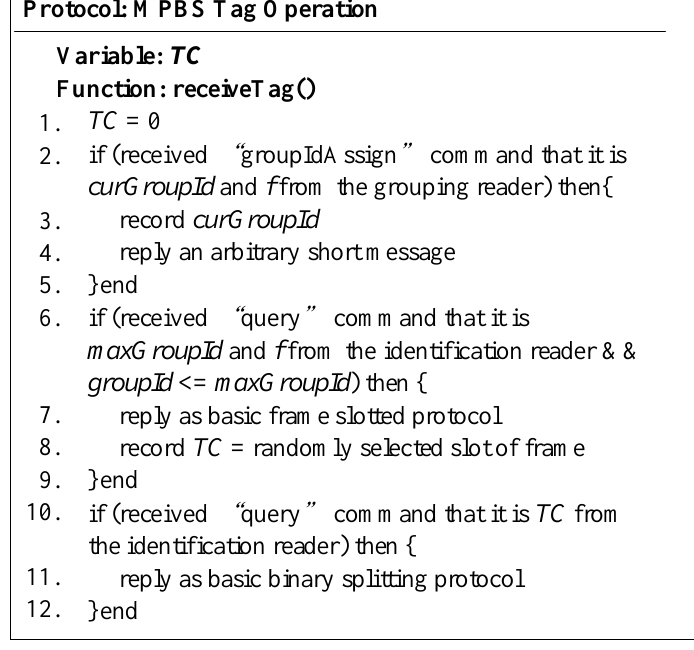
Figure 10. Tag code operation.